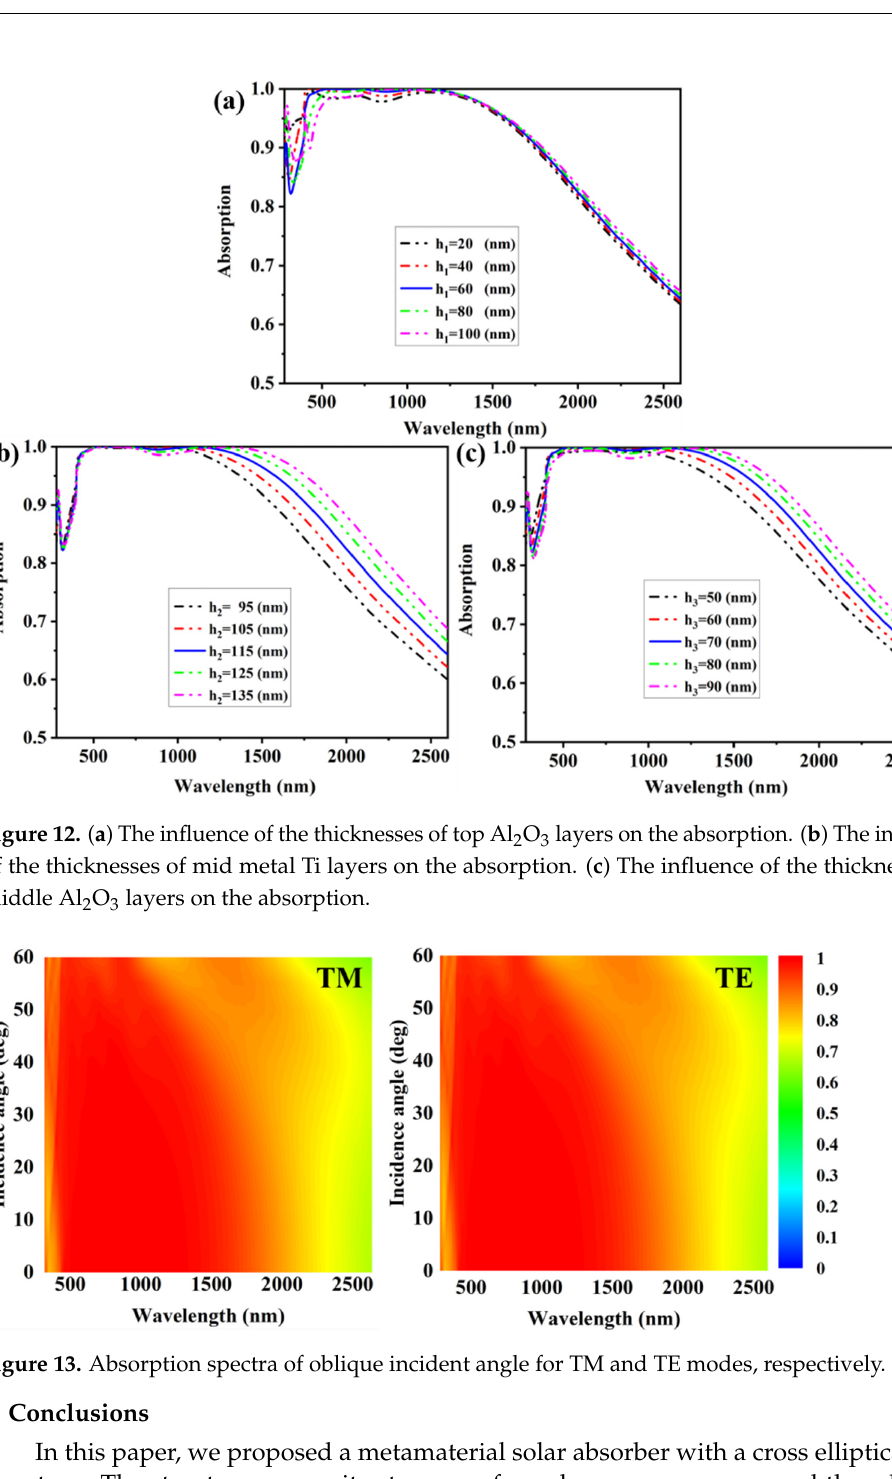
Figure 13. Absorption spectra of oblique incident angle for TM and TE modes, respectively.